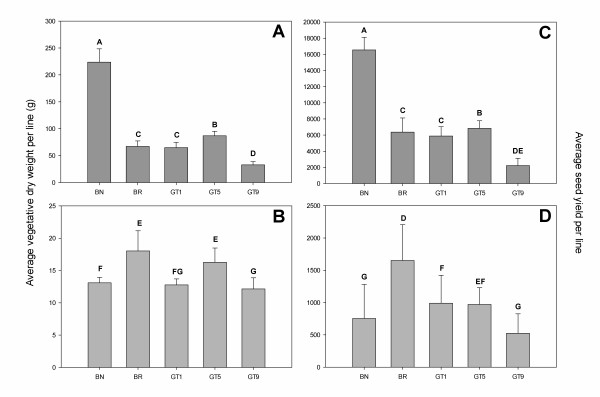
Genetic Load Study: Productivity. Average vegetative dry weight and seed yield (2e +4 = 20,000 seeds, 1e + 5 = 100,000 seeds, etc.) of non-transgenic Brassica napus (BN), Brassica rapa (BR) and transgenic BC1/F2 hybrid lines (GT1, GT5 and GT9) grown under non-competitive (A and C) and competitive field conditions (B and D). Columns with the same letter do not differ statistically (P < 0.0001). Error bars represent ± standard error of the means. Note that different Y-axis scales are used among figure panels.